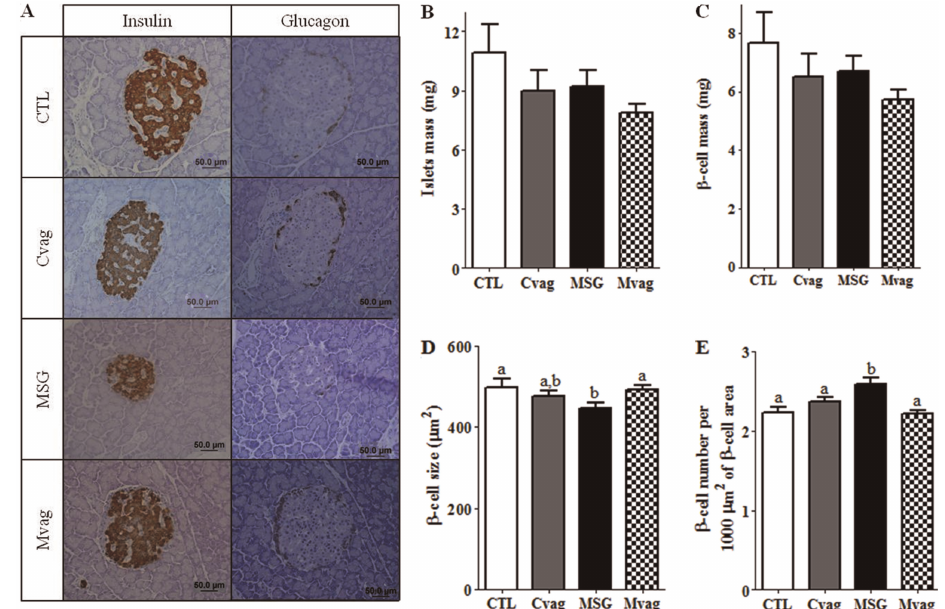
Figure 6. Representative images of pancreas sections stained for insulin or glucagon and hematoxylin ( A ). Islet mass ( B ), b -cell mass ( C ), b -cell size ( D ) and b -cell number ( E ) in the pancreas of 90-day-old control (CTL), CTL with subdiaphragmatic vagotomy (Cvag), monosodium glutamate (MSG) and MSG with subdiaphragmatic vagotomy (Mvag) rats. Data are reported as means±SE (n=4). Different letters indicate statistically significant differences (two-way ANOVA followed by Duncan’s post-test, P # 0.05).